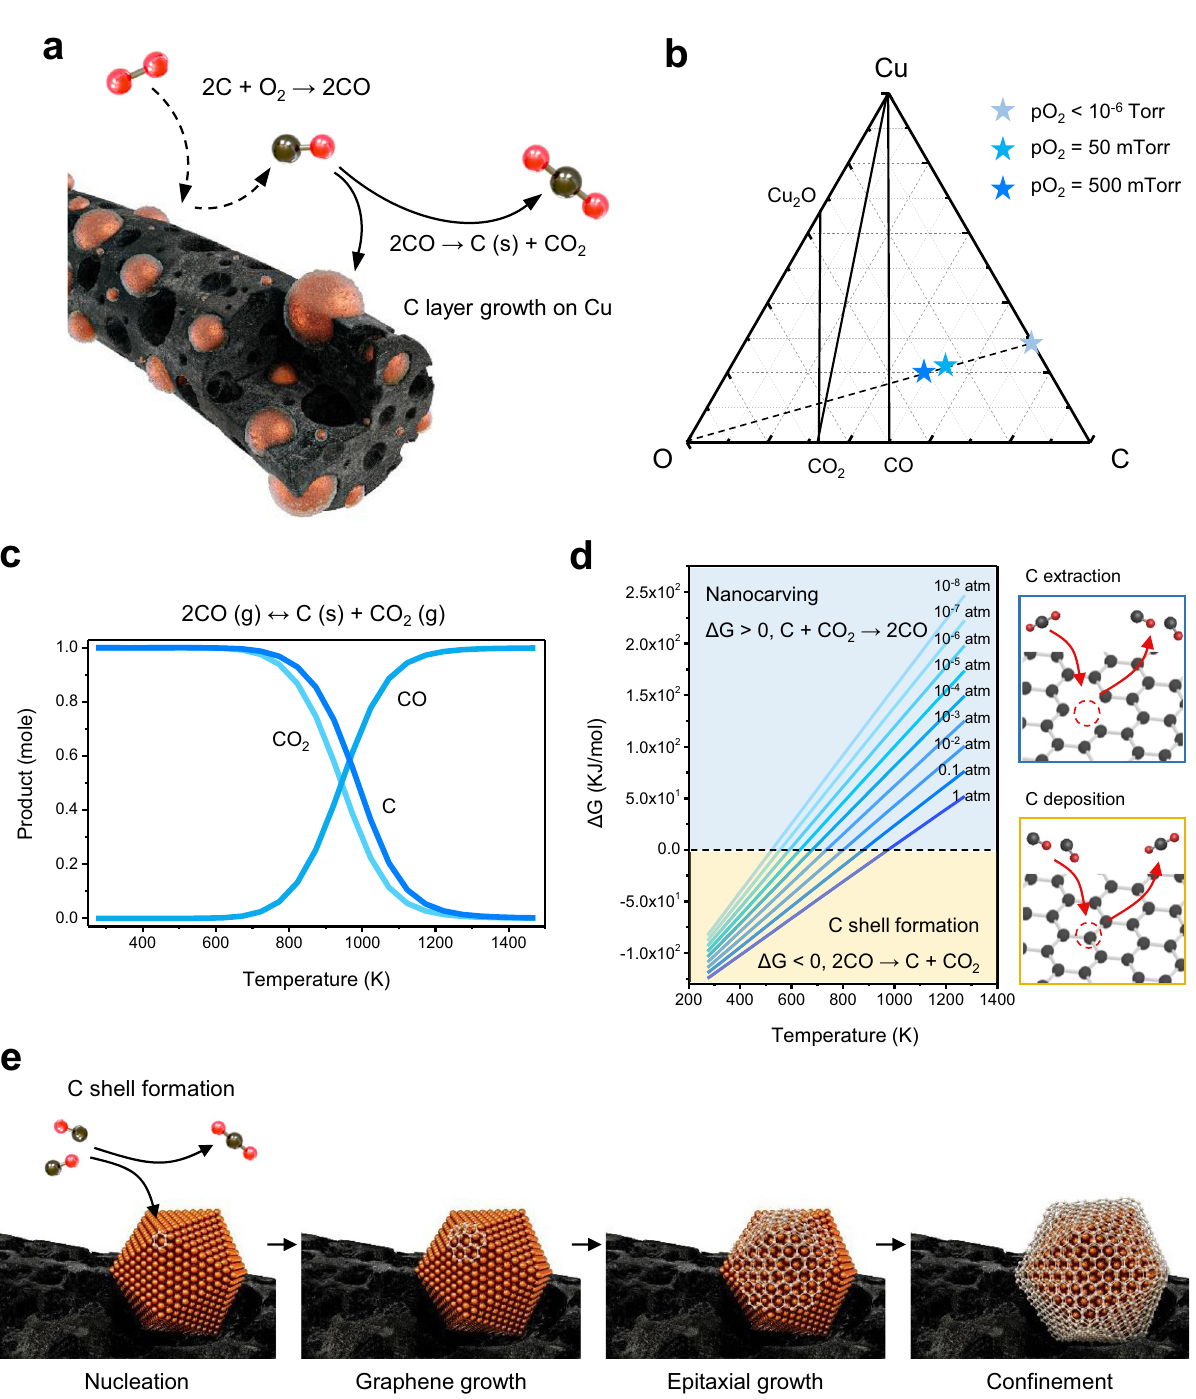
Fig. 1 Con fi nement of Cu nanoparticles by the quasi-graphitic C shell and the thermodynamics based on the Boudouard reaction. a Schematic illustration of the CO-mediated reaction in the Cu – C – O system. The C matrix was nanocarved, forming inner pores by C combustion and generating CO- con fi ned Cu nanoparticles in a quasi-graphitic C shell. The dotted line shows nanocarving, and the solid line shows the Boudouard reaction. b Ternary phase diagram (Cu – O – C) at 800 °C. Each point indicates the composition conditions representing the pO 2 . It is con fi rmed that the experimentally conducted conditions are in Cu – CO – C stable regions. c Thermodynamically stable product of the reversible Boudouard reaction corresponding to the temperature under 1 atm. d Plot showing the Gibbs free energy of the Boudouard reaction vs. temperature under different total pressures from 10 − 8 to 1 atm. The upper (lower) area indicates favorable forward (backward) reaction conditions. The schematic fi gures on the right describe C extraction and C deposition that reversibly progress depending on the sign of Δ G . e Formation mechanism of the quasi-graphitic C shell on Cu nanoparticles through the disproportionation of